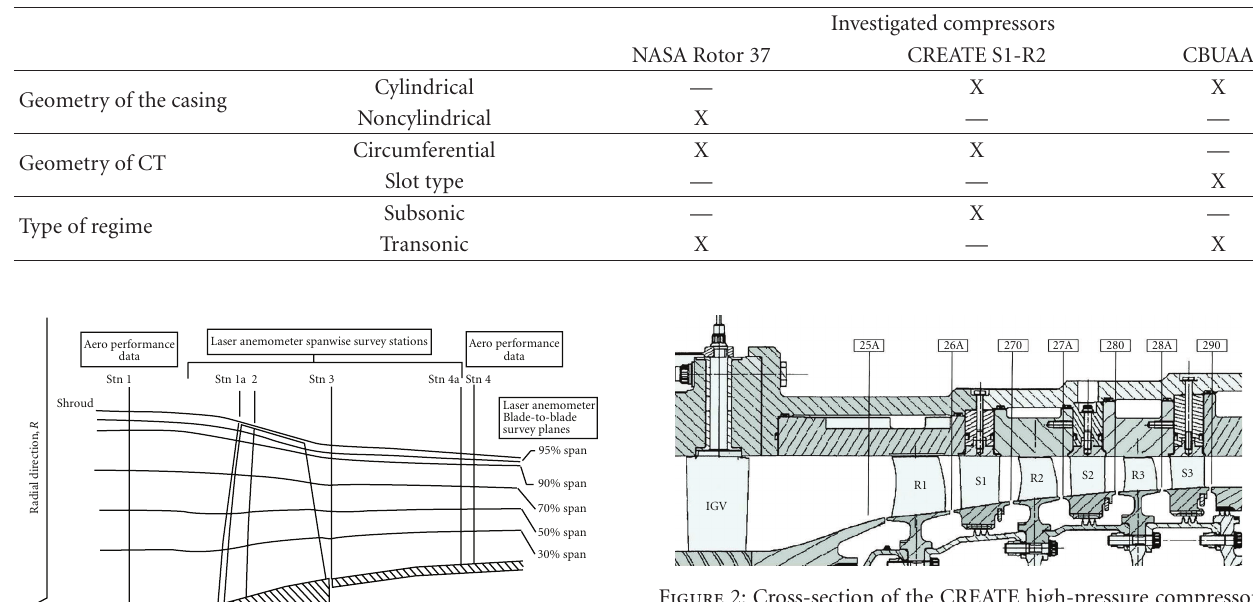
Table 1: Di ff erences between the axial compressors investigated.